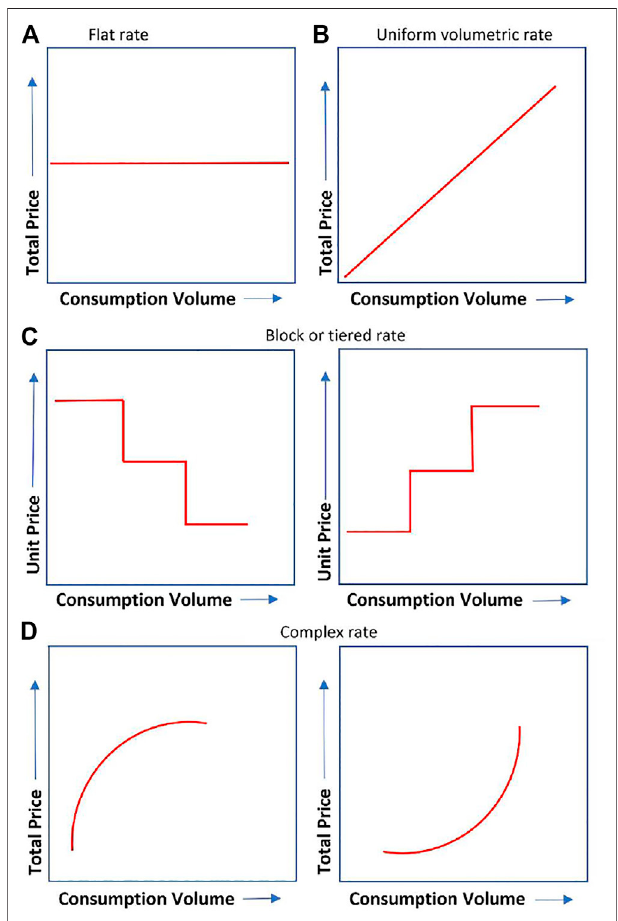
FIGURE 4 | Tiered systems, adapted from Rios et al.